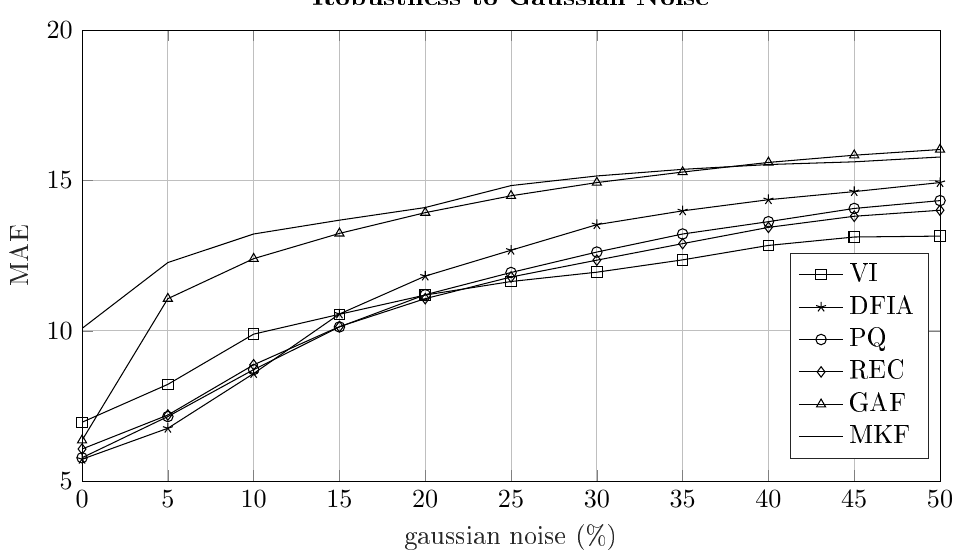
Figure 6. Influence of the noise level on the performance of energy disaggregation for different time series imaging